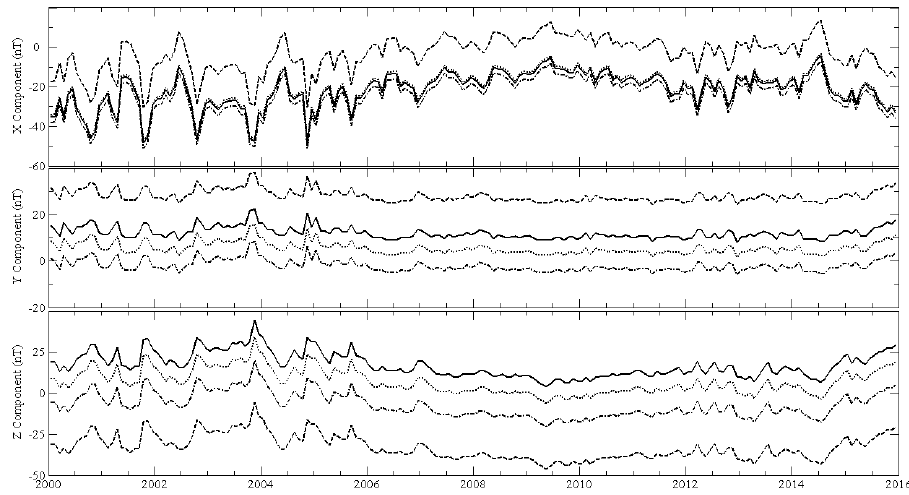
Figure 6. X, Y, Z - component differences between monthly mean values at NGK observatory and respective values predicted by EMM2015 model with maximum degrees L : a) 720 (dash-dotted line), b) 520 (solid line), c) 320 (dotted line), d) 120 (dashed line).